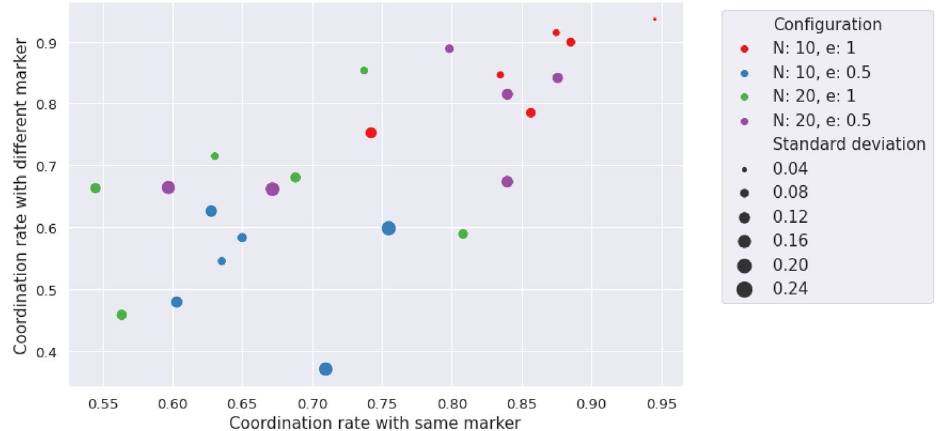
Figure 3. Coordination with agents with same and different marker for different e and group size. Groups are characterized by four different configurations according to these parameters: { N , e } = {{ 10, 0.5 } , { 10, 1 } , { 20, 0.5 } , { 20, 1 }}